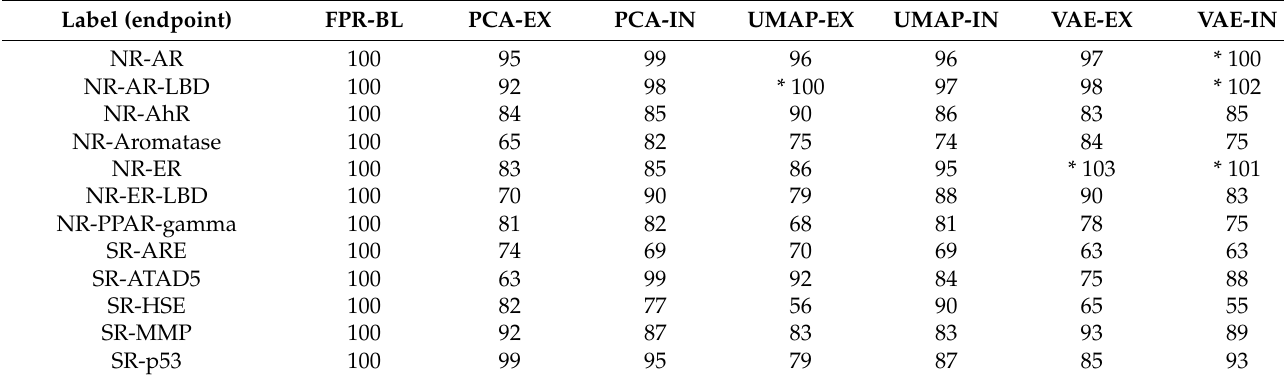
Table 3. Classification results across all data sets and labels expressed by maximum values of the